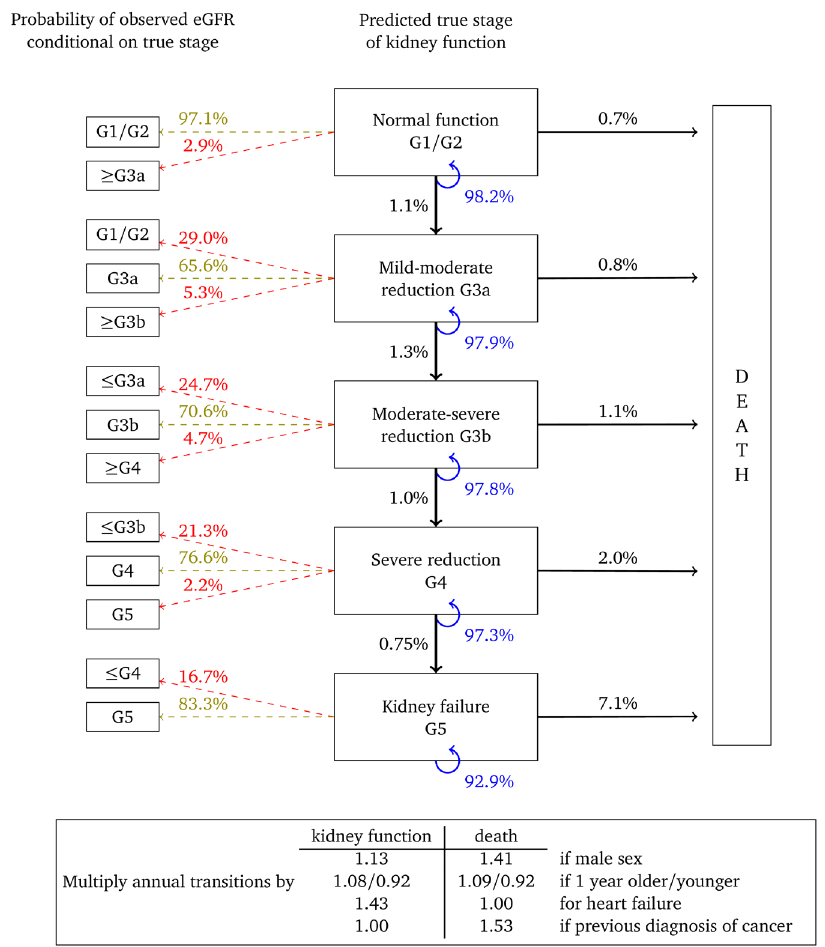
Figure 2. Annual transition model diagram for patients with unmeasured urine albumin at baseline. Probabilities are based on a woman aged 60, without heart failure or a previous diagnosis of